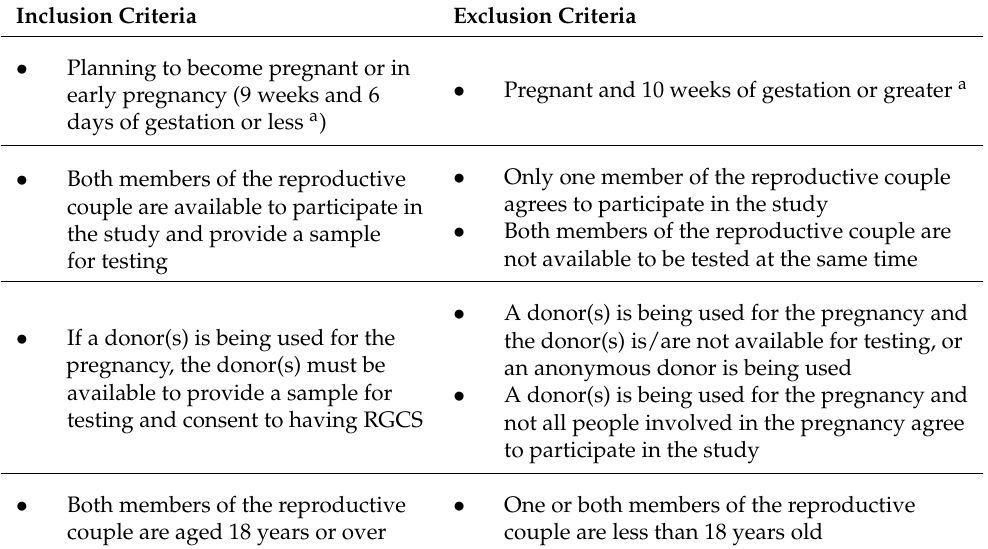
Table 1. Inclusion and exclusion